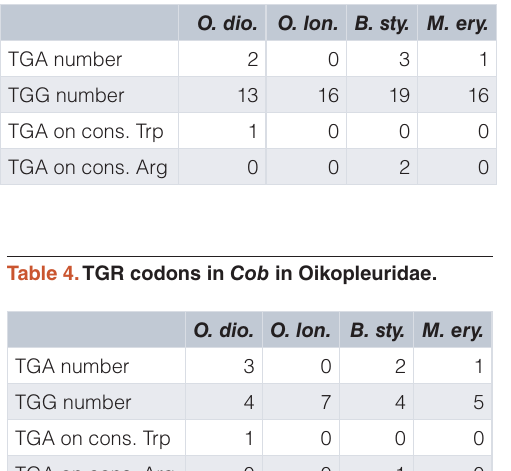
Table 3. TGR codons in Cox1 in Oikopleuridae.